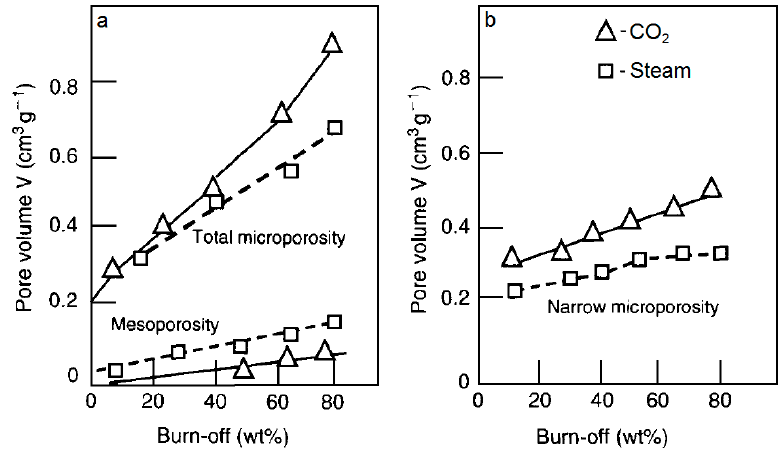
Figure 5. Evolution of micropore and mesopore volumes ( a ) and volume of narrow micropores ( b ) as a function of burn-off in CO 2 and steam from olive stone. Reproduced from [50] with permission from Elsevier © 1995.